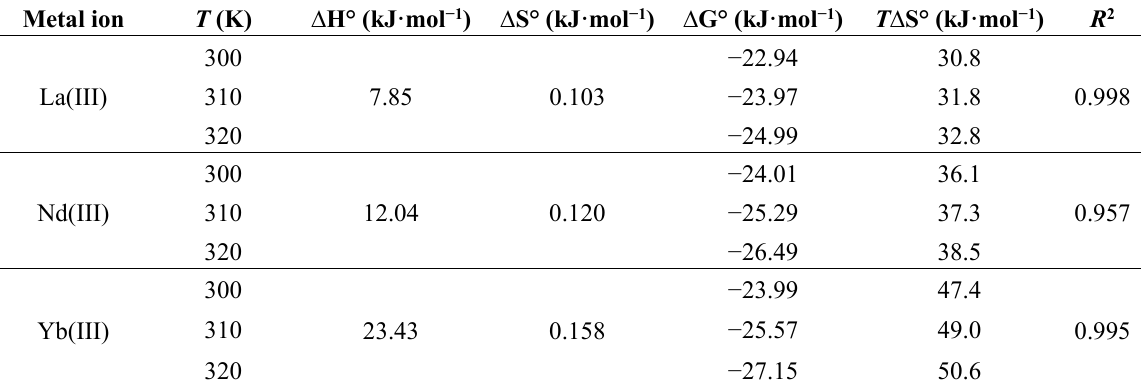
ions using cysteine-based magnetic-chitosan nano-based particles at different temperatures.